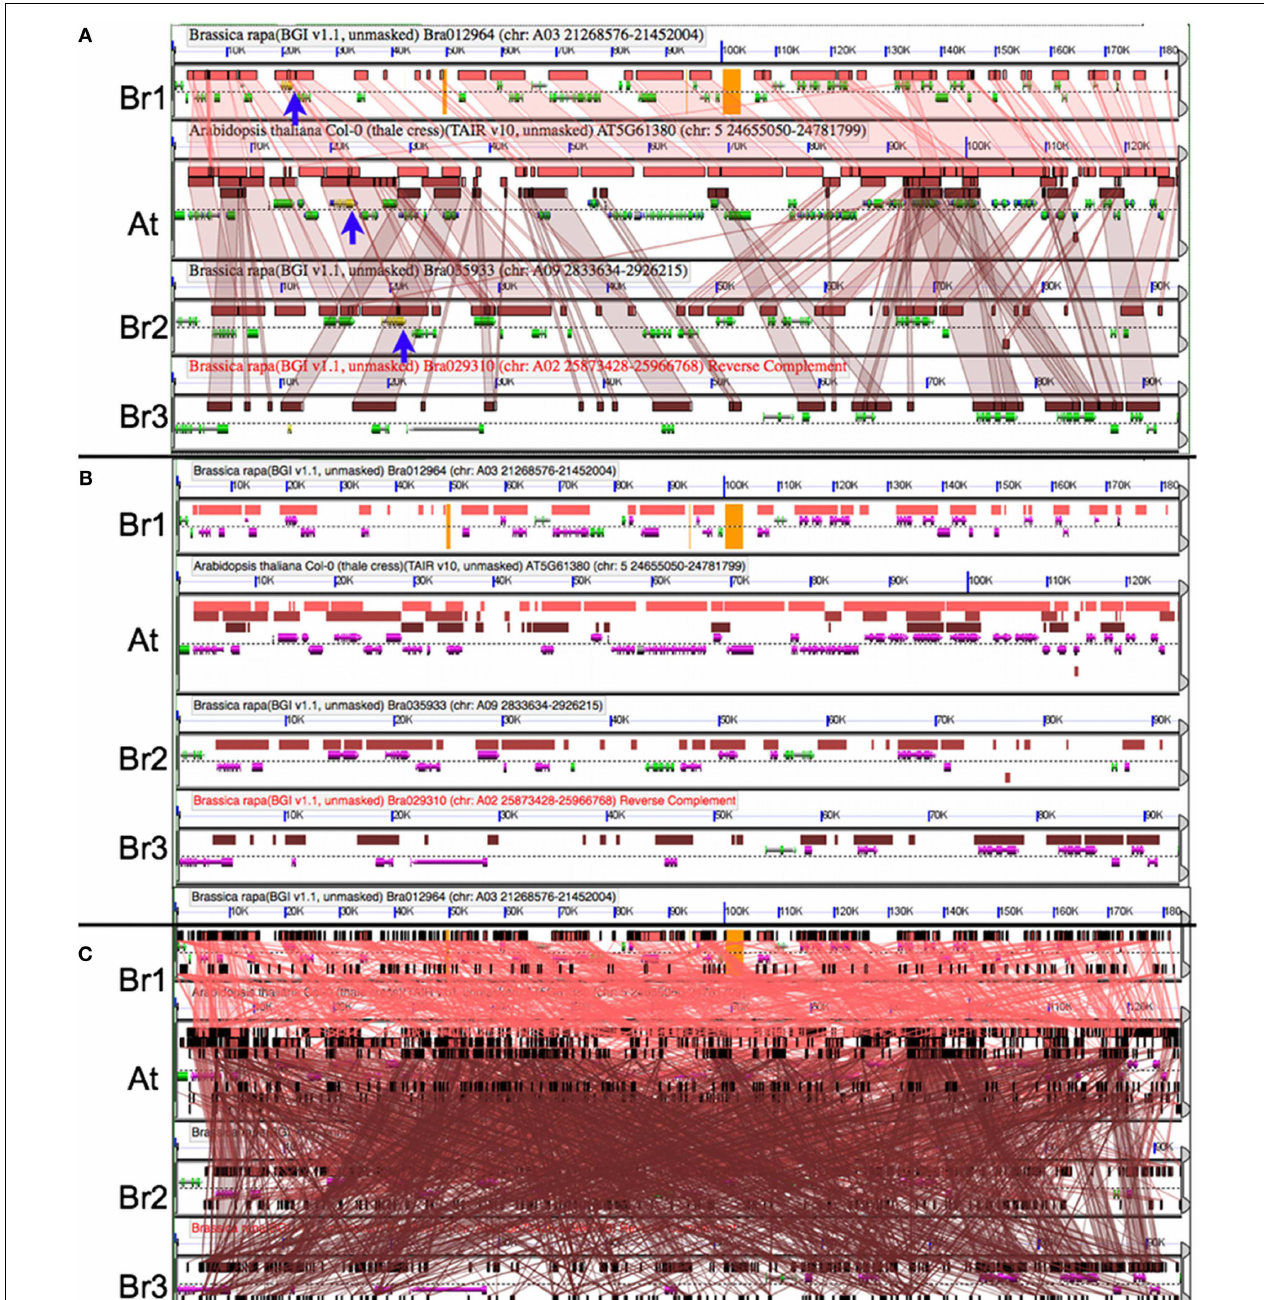
LASTZ. Results may be regenerated: http://genomevolution.org/r/4sma. (B) Fractionation of Br’s gene content; LASTZ comparison to At’s gene content. Genes covered by a region of sequence similarity are colored purple. Note that At’s gene content is represented among the combined Br regions. Results may be regenerated: http://genomevolution.org/ r/4smb. (C) Picking the wrong algorithm for the comparison. BLASTN with settings for detecting CNSs used to compare sequences results in too many non-syntenic regions of sequence similarity. Results may be regenerated: